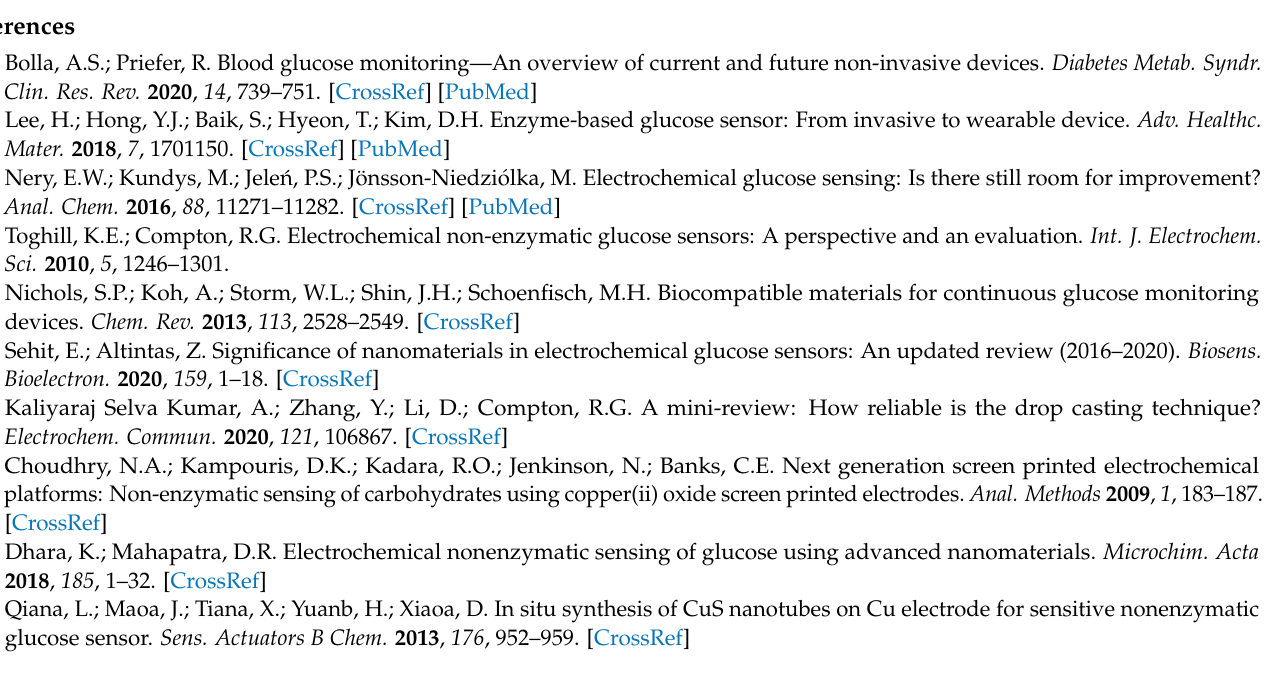
(c) PVP_1.0/25%. Figure S6: Amperometric responses to glucose in the concentration range 0 − 6 mM